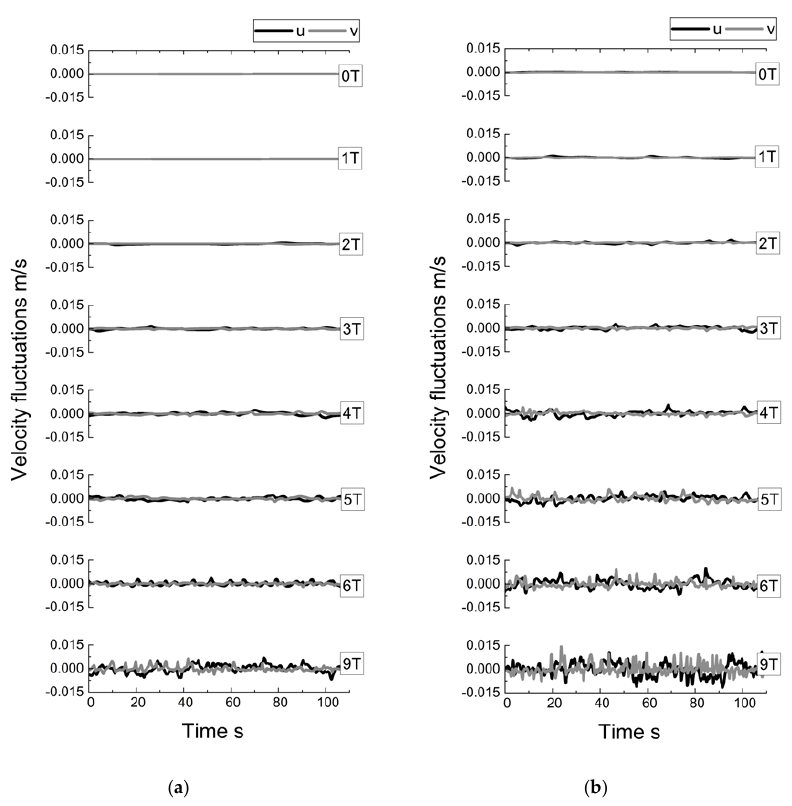
Figure 12. Velocity fluctuations for the numerical case with ( a ) Δ T = 5 °C and ( b ) Δ T = 11 °C .